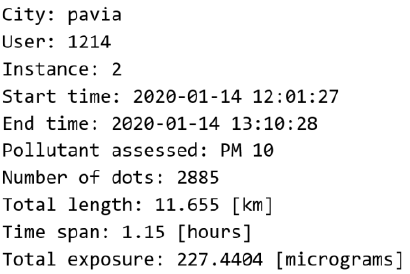
Figure 21. Summary statistics